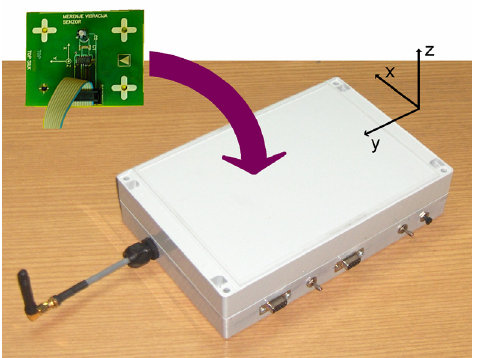
Figure 3 – Sensor device in its plastic housing Рис . 3 – Устройство в пластиковом